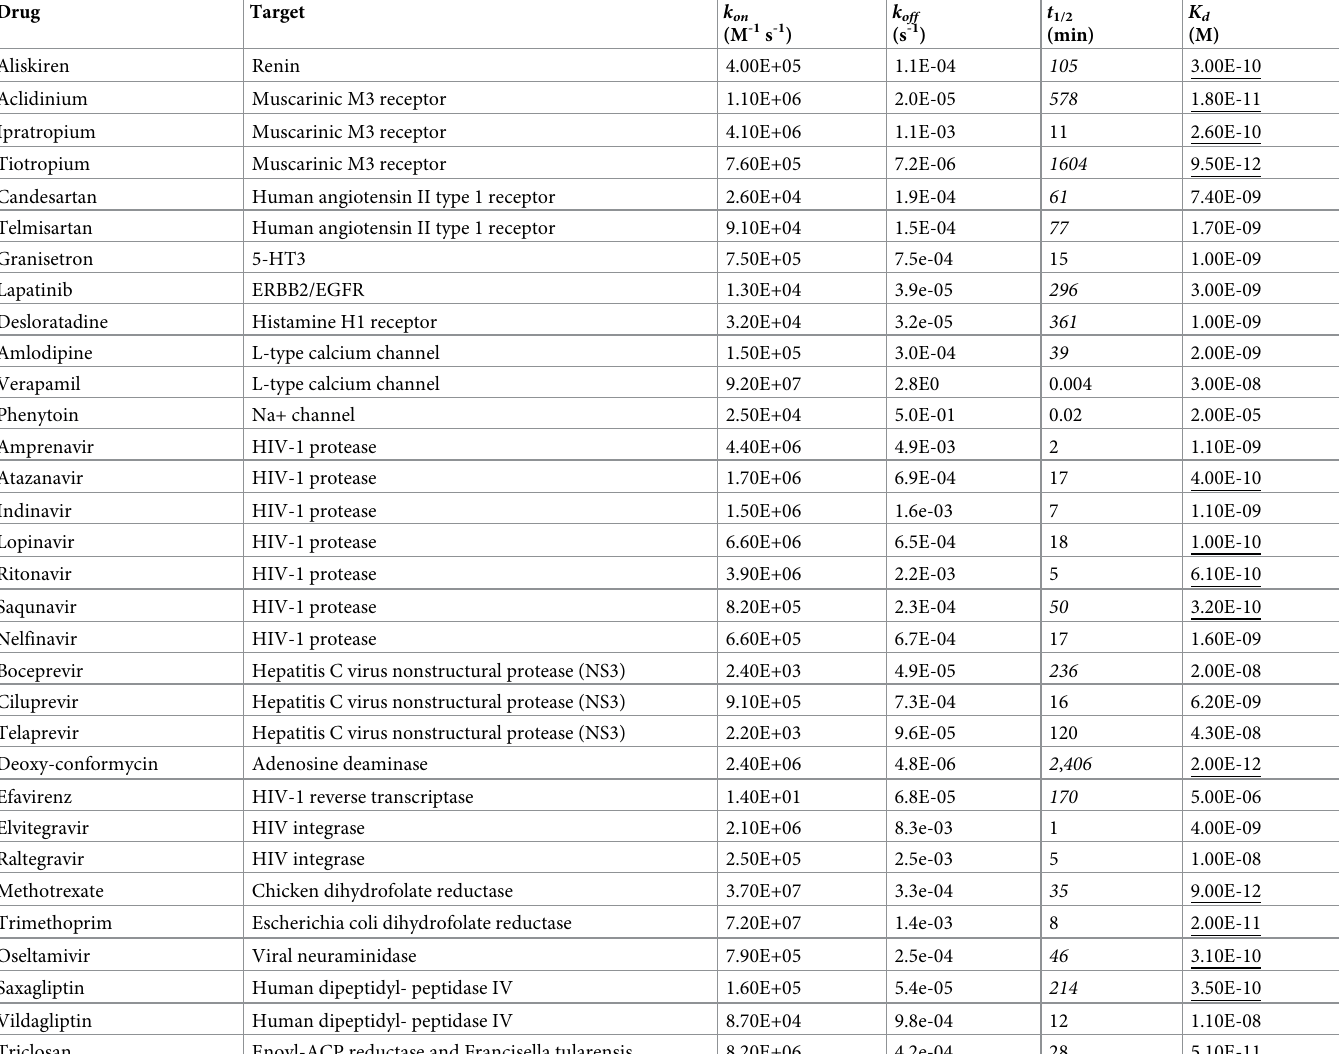
Table 4. Published k on , k off , and K d values for a set of marketed drugs [29]. The drugs are grouped by target. Cases of K d < 1 nM are underlined, k on > 1x10 5 M -1 s -1 are shown in bold, and t 1/2 > 30 min are